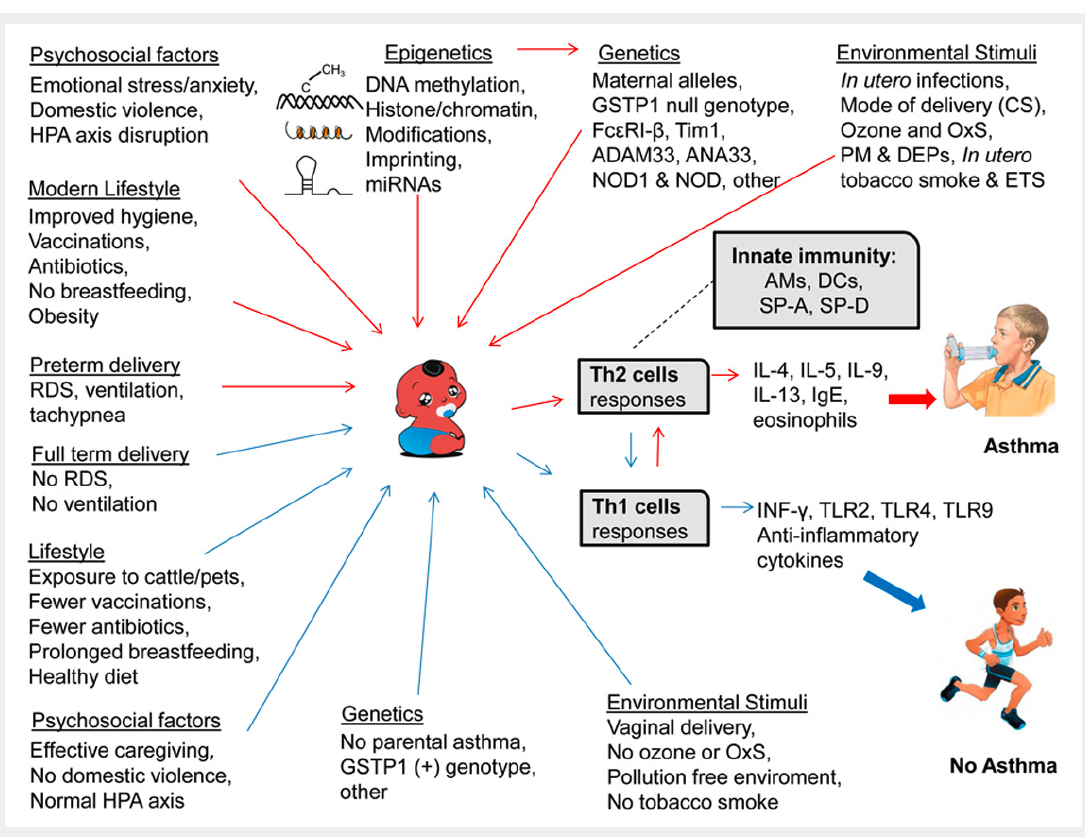
Diagrammatic summary of childhood asthma causes, risks and protective factors. The figure depicts the causes and the risk factors of childhood asthma that include genetics, epigenetics and environmental insults. These favour the Th2 biased cell response and select against Th1 cell response leading to inflammation and exacerbation of asthma (red arrows). The figure shows the factors leading to the Th1 cell response that produces anti-inflammatory cytokines and these in turn protect against asthma (blue arrows). The role of innate immunity in asthma, as exemplified by AMs, DCs, SP-A and SP-D is also noted with a broken line. The human cartoons were taken from Google. (Infant cartoon: http://123freevectors.com/black-baby/#.UVtFcFdyPfo, Asthmatic child: http://krames.sjmctx.com/HealthSheets/3,S,88710, Healthy child: